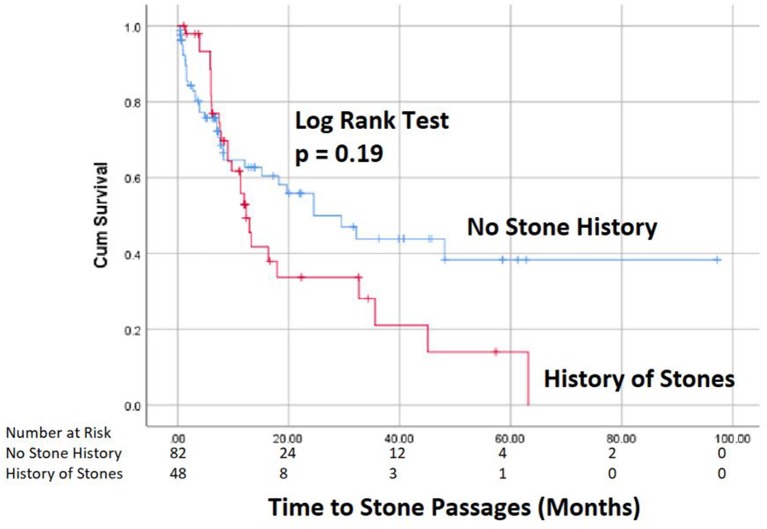
Kaplan Meier Curve for stone passage.